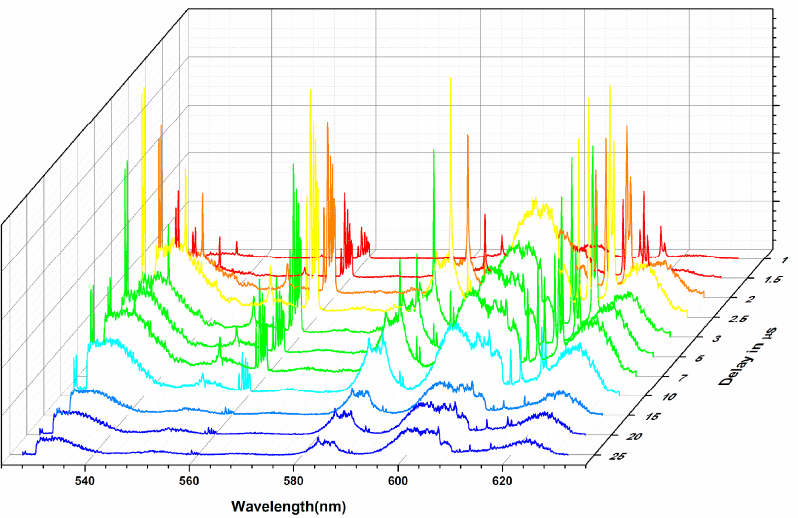
Figure 5. LIBS spectra of green zone recorded at different gate delays representing the evolution of molecular band of CaF over time.